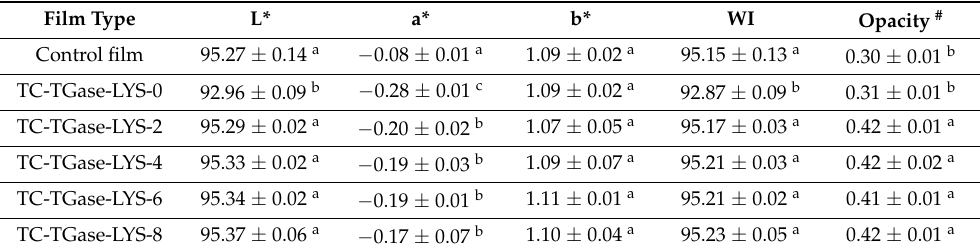
Table 1. Color attributes and opacity of transglutaminase (TGase) cross-linked tilapia collagen (TC) films incorporated with lysozyme (LYS).